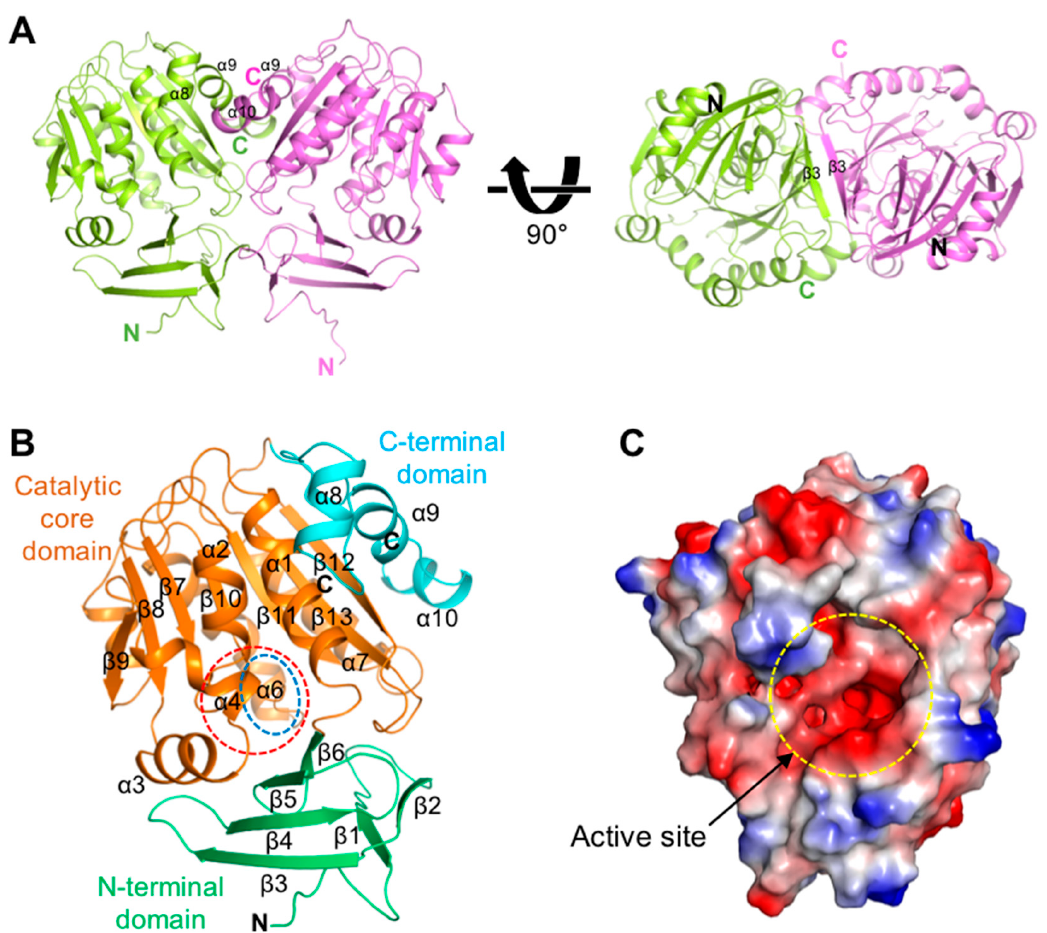
Figure 1. Overall structure of spermidine synthase (SpdS) from Kluyveromyces lactis ( Kl SpdS). ( A ) The dimeric structure of Kl SpdS is shown as a cartoon. Chain A is shown in lime green, and chain B is shown in pink. Different view of 90 ◦ rotation along the x -axis is shown in right panel. ( B ) Monomeric structure of chain B in Kl SpdS. The N-terminal domain is colored green. The catalytic core domain is shown in orange. The C-terminal domain is shown in cyan. The active site of Kl SpdS is highlighted in the red-dashed circle. The gate-keeping loop is highlighted in the blue-dashed circle. ( C ) Electrostatic surface model of the Kl SpdS monomer. Red and blue represent negatively and positively charged surfaces, respectively. The active site of Kl SpdS is highlighted in the yellow-dashed circle.